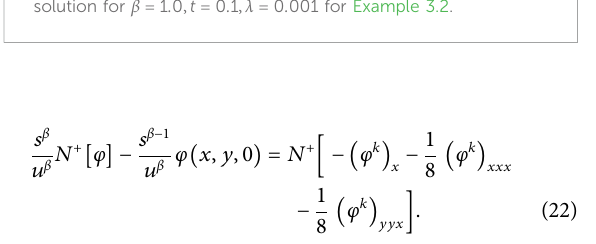
FIGURE 2 3D plots obtained by the fi rst order (A) NTIM and (B) exact solution for β (cid:2) 1 . 0 , t (cid:2) 0 . 1 , λ (cid:2) 0 . 001 for Example 3.2.